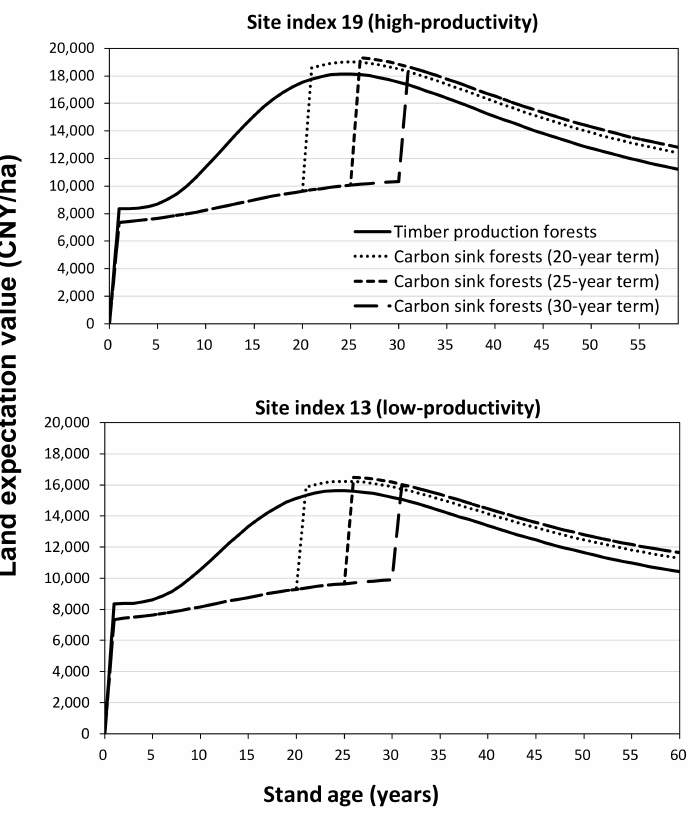
Figure 2. Land expectation values for larch timber production forests and larch carbon sink forests in Gansu, Northwest China. The carbon sink forests were evaluated under a theoretically optimal carbon trading price (CNY 110/tCO 2 e). Site index (SI) represents the top height (in meters) at a breast height age of 18